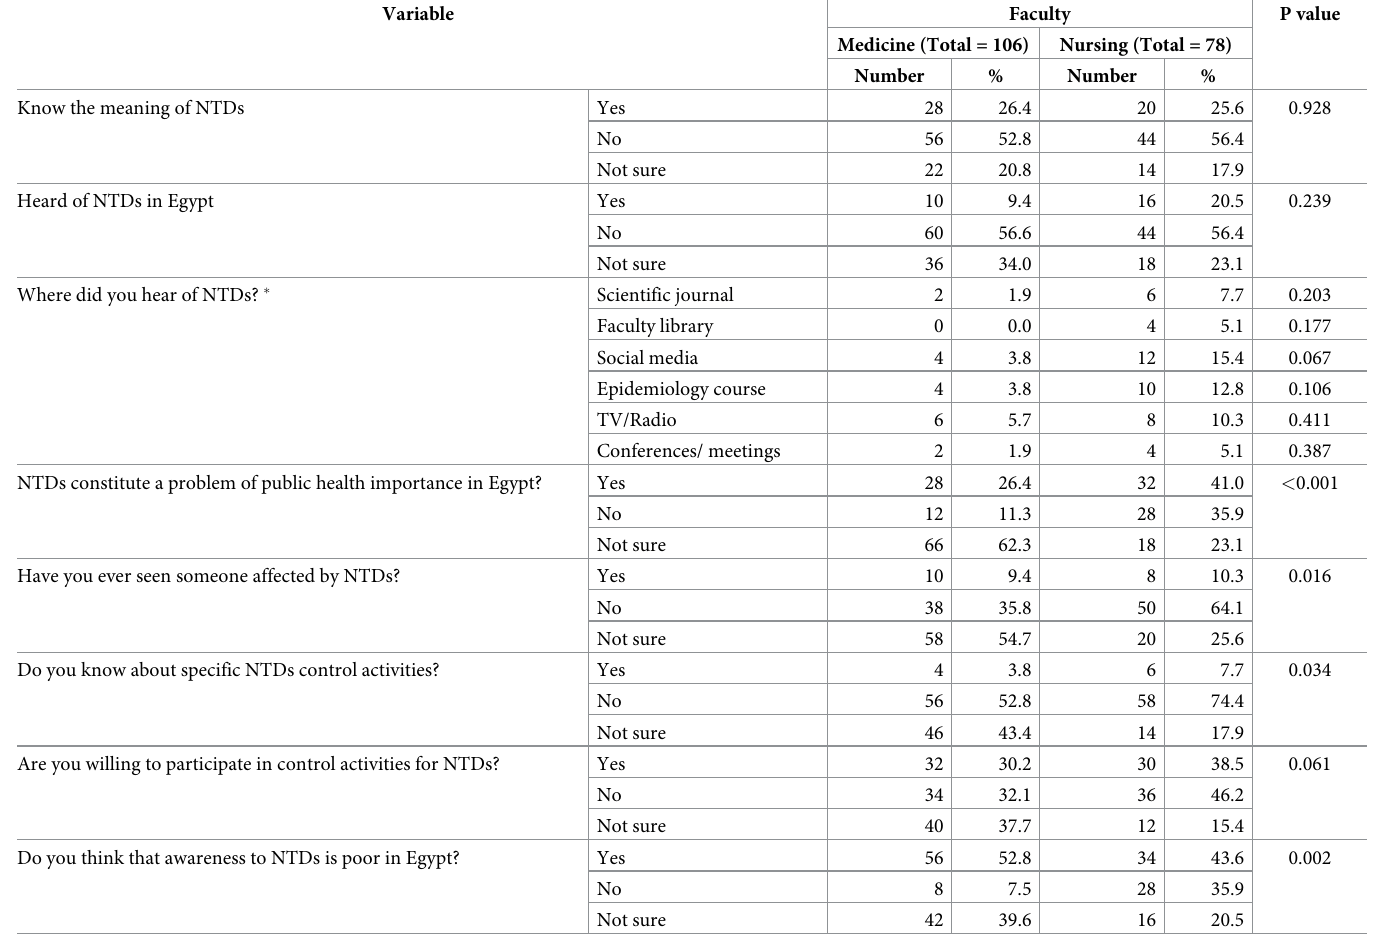
Table 4. Comparison between the knowledge of the included medical and nursing students about NTDs in Cairo